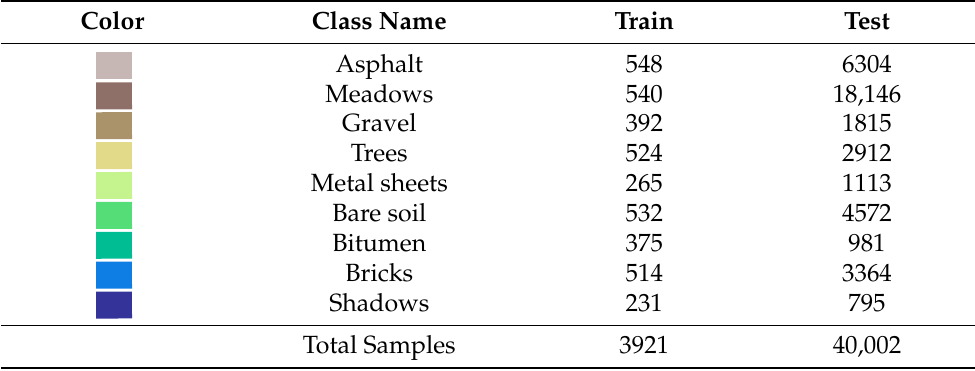
Figure 11. ISPRS HyRANK dataset. ( a ) False-color image of the Dioni scene. ( b ) Ground truth of the Dioni scene. ( c ) False-color image of the Loukia scene. ( d ) Ground truth of the Loukia scene. The available labeled pixels in the Dioni and Loukia hyperspectral scenes are used as the training and test sets, respectively. Table 2. The number of standard training and test samples in UP dataset.